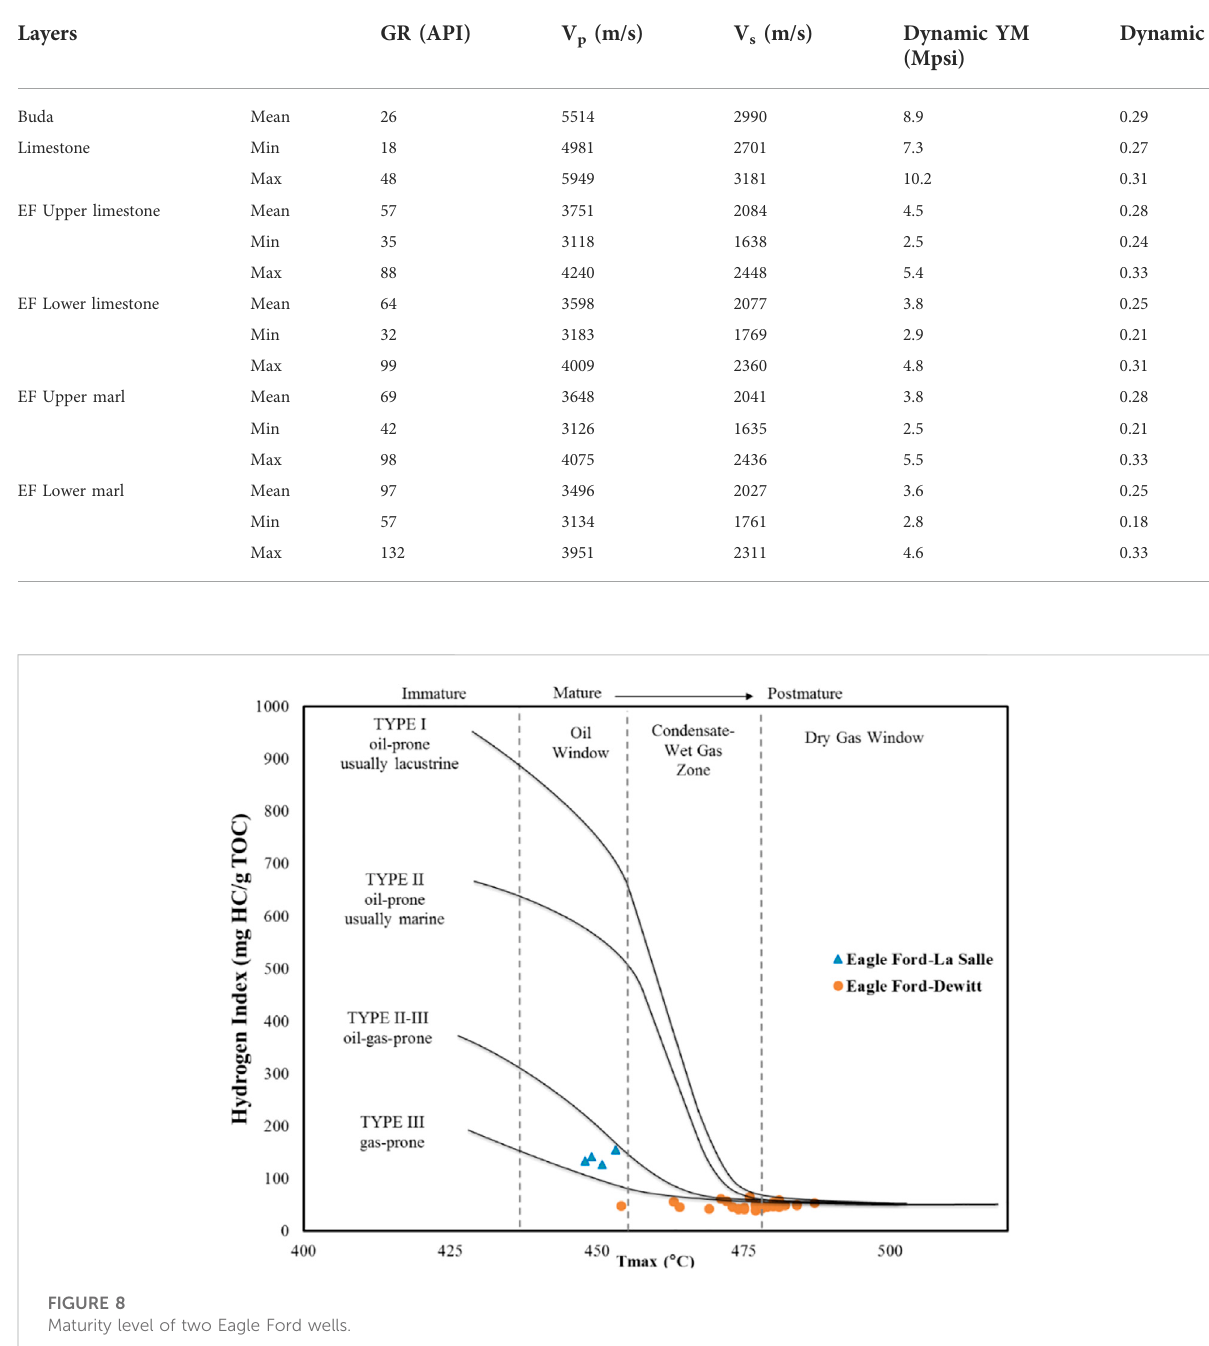
TABLE 3 Summary of parameters in different layers of the Eagle Ford and adjacent formation in Dewitt County.